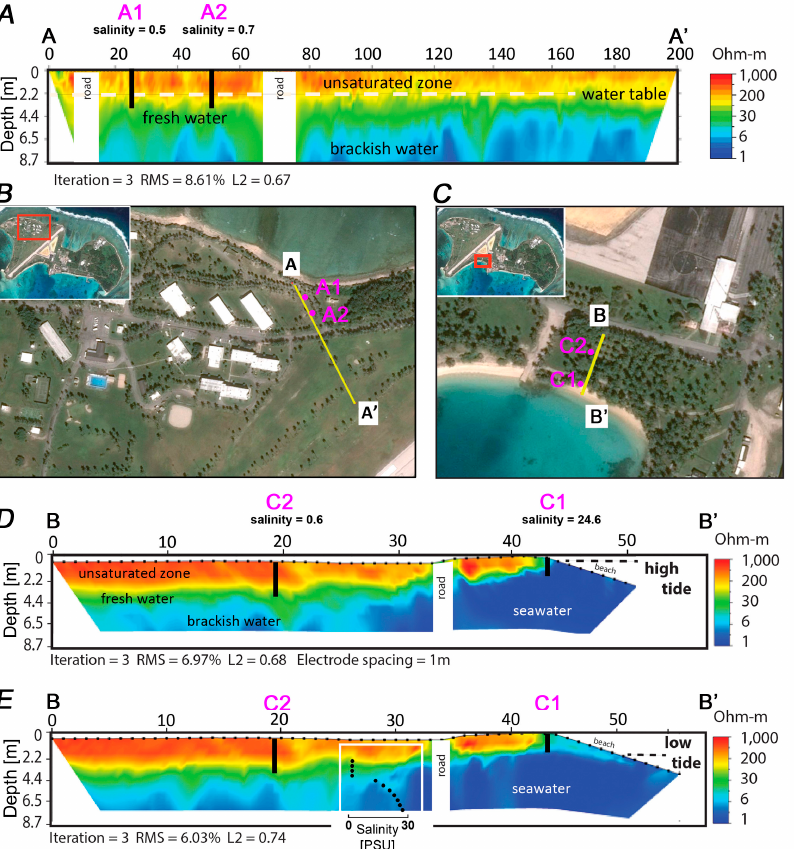
Figure 2. Locations and examples of Electrical Resistivity Tomography (ERT) profiles; ( A ) ERT profile A–A’ on the ocean side of Roi; ( B ) Map showing location of ERT profile A–A’; ( C ). Map showing location of ERT profile B–B’; ( D ). ERT profile B–B’ on the lagoon side of Roi at high tide; ( E ). ERT profile B–B’ on the lagoon side of Roi at low tide. The locations of wells A1, A2, C1, and C2 are denoted in magenta. The pore water salinity profile shown in the lower image was obtained using a drive point piezometer, as described in Section